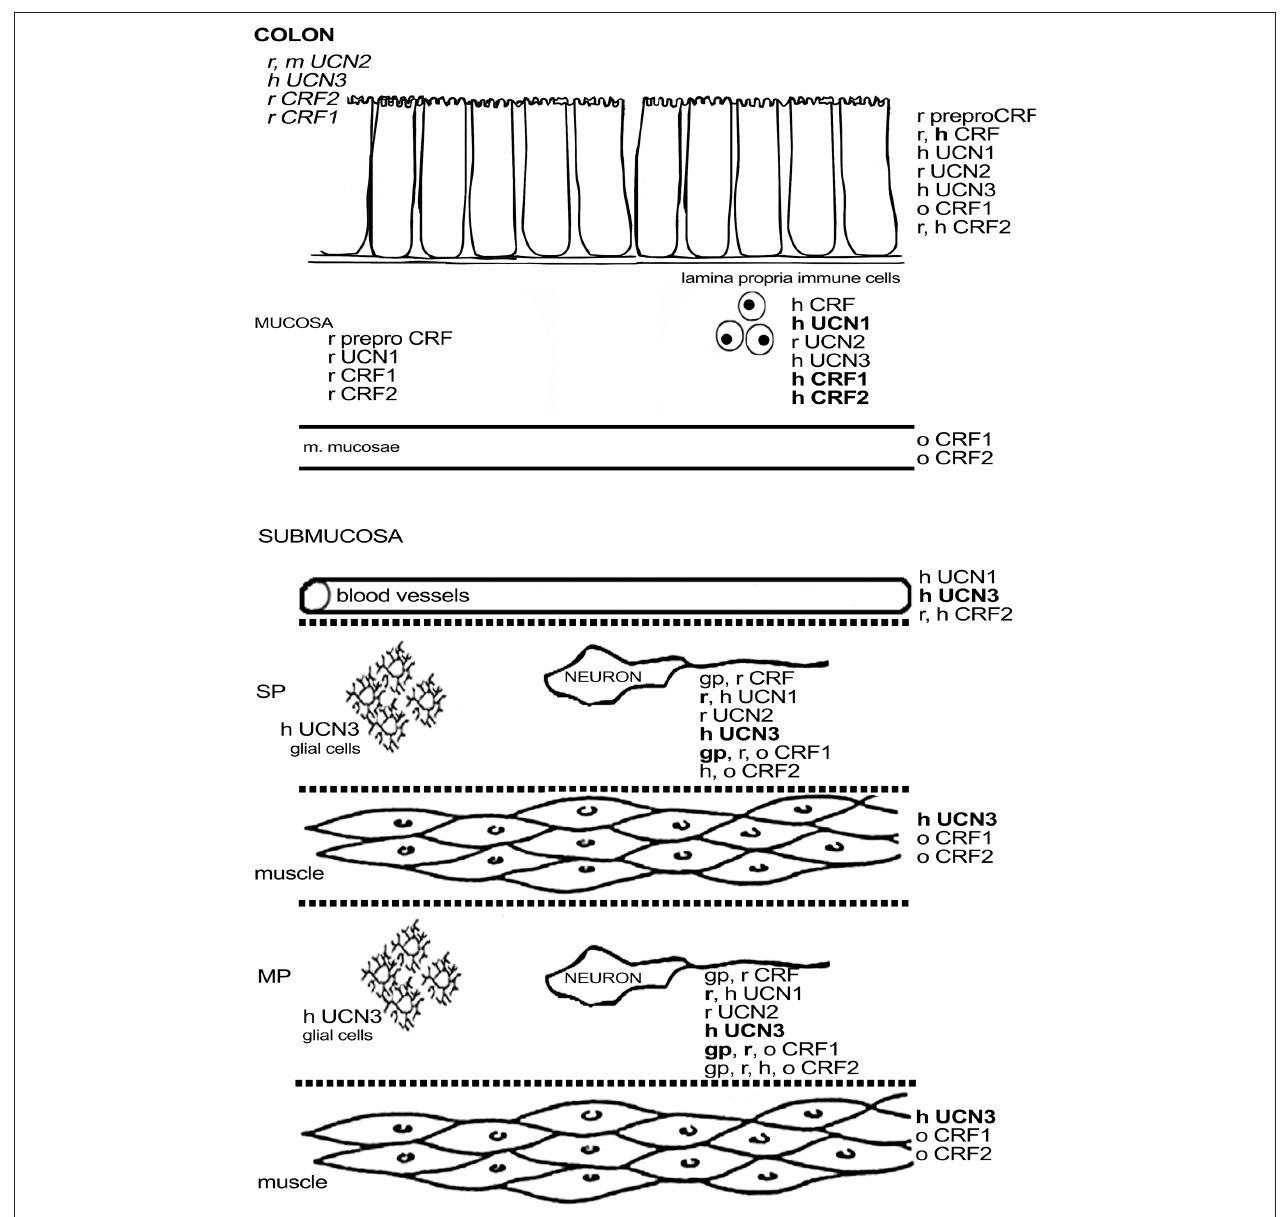
Figure 3 | Schematic overview of the expression of CrF-related proteins in the colon. Regular font indicates that protein expression has been described, italic font indicates that mRNA expression has been described, bold font